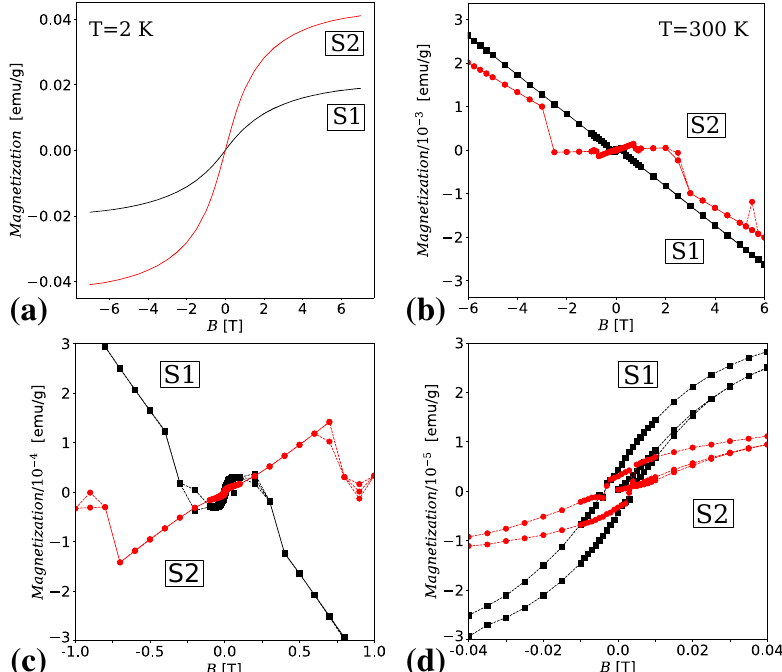
Figure 6. Magnetization vs. dc magnetic field B for samples S1 and S2 at temperature T = 2 K ( a ), and T = 300 K ( b ). Panels ( c , d ) show the enlarged fragments of the plots in panel ( b ) for B in the range of − 1 to 1 T and − 0.04 T to 0.04 T, respectively.